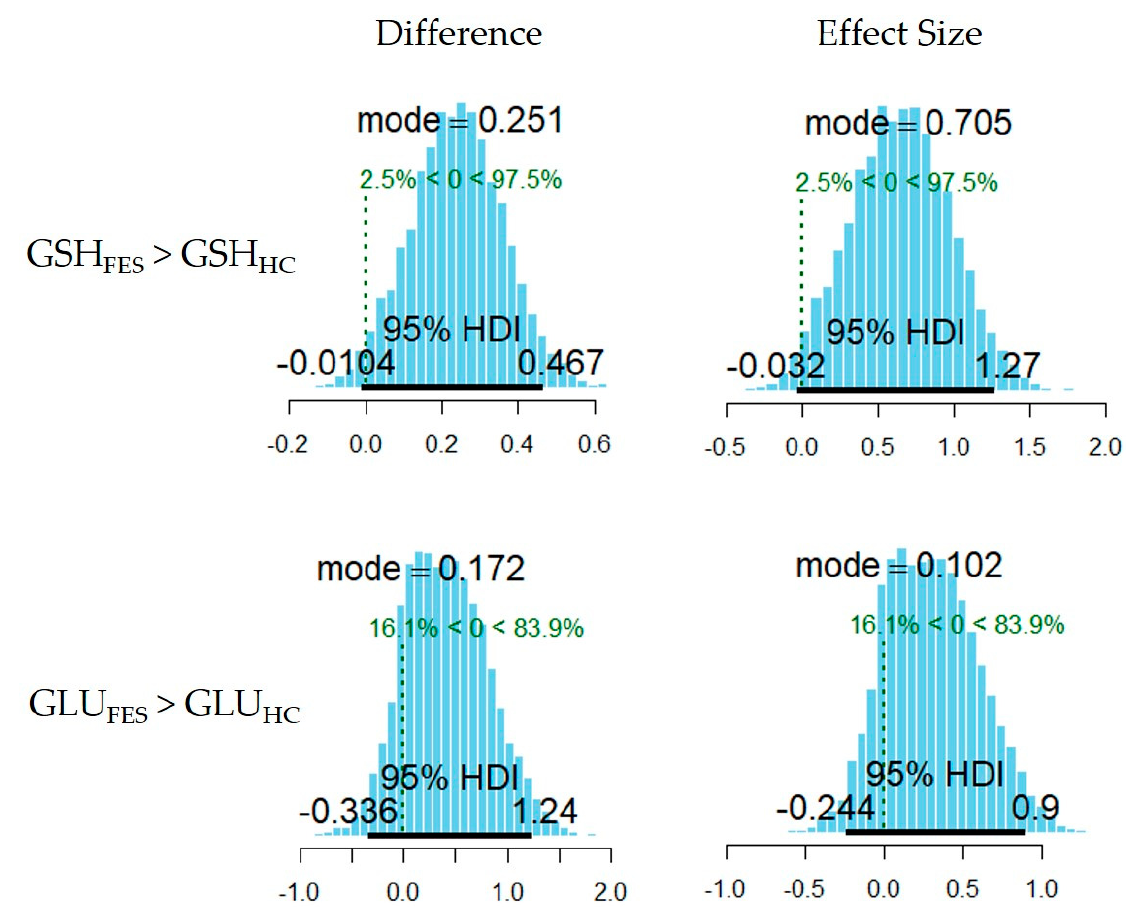
Figure 3. Posterior distributions of the estimated between-group differences and effect sizes in GLU (lower panels) and GSH (upper panels) levels.